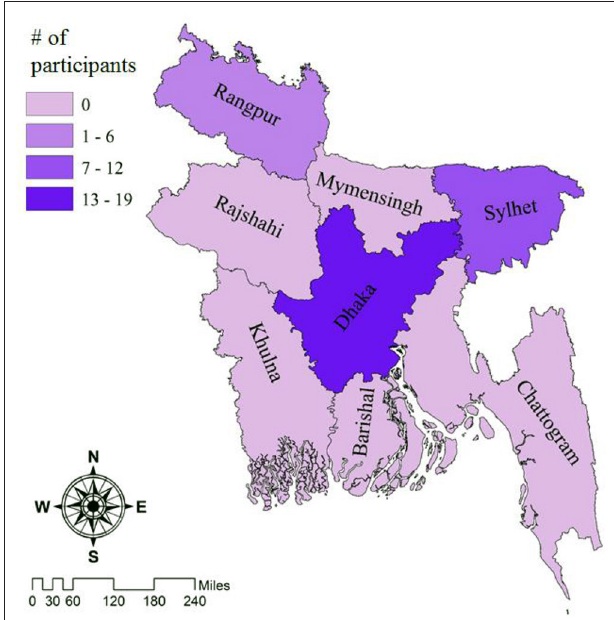
FIGURE 1 | Map of Bangladesh presenting the participants’ living